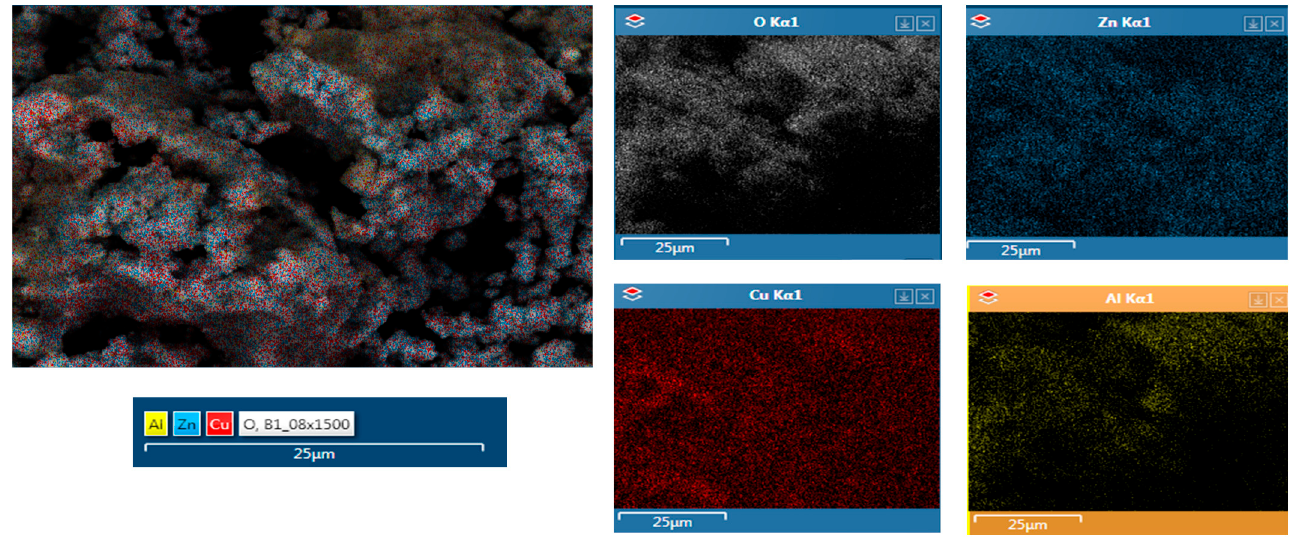
Figure 3. EDS mapping of CZA-30 ′ .